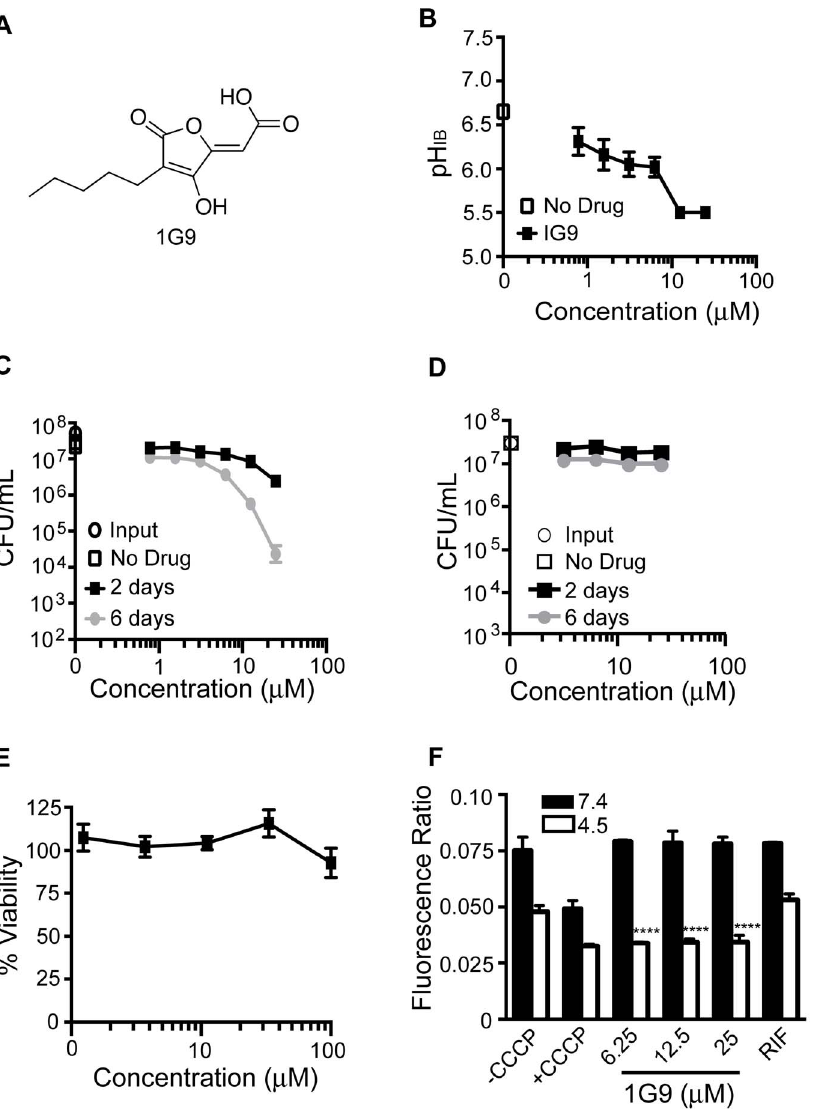
Figure 5. Effect of 1G9 on pH IB , survival, and membrane potential of Mtb and on Vero green monkey kidney cells. (A) Structure of 1G9. (B) pH IB was measured following exposure of H37Rv-pHGFP to increasing concentrations of 1G9 for two days at 37 u C. (C and D) Survival of H37Rv- pHGFP following exposure to increasing concentrations of 1G9 at pH 4.5 (C) and pH 7.4 (D) for two and six days. Means 6 SEM of triplicate samples from two experiments are shown. (E) Vero cells were exposed to varying concentrations of 1G9 for two days at 37 u C and viability assessed microscopically and by a tetrazolium (MTS) reduction assay. Results represent two independent experiments, each performed in triplicate. Mean 6 standard deviations are shown. (F) H37Rv treated with DMSO, CCCP, RIF (0.4 m g/mL), or 1G9 at pH 7.4 or 4.5 was exposed to the membrane potential sensitive dye, DiOC 2 . Results represent means 6 standard deviations for two independent experiments, each performed in triplicate. The p value was determined using an unpaired t test: ****p ,